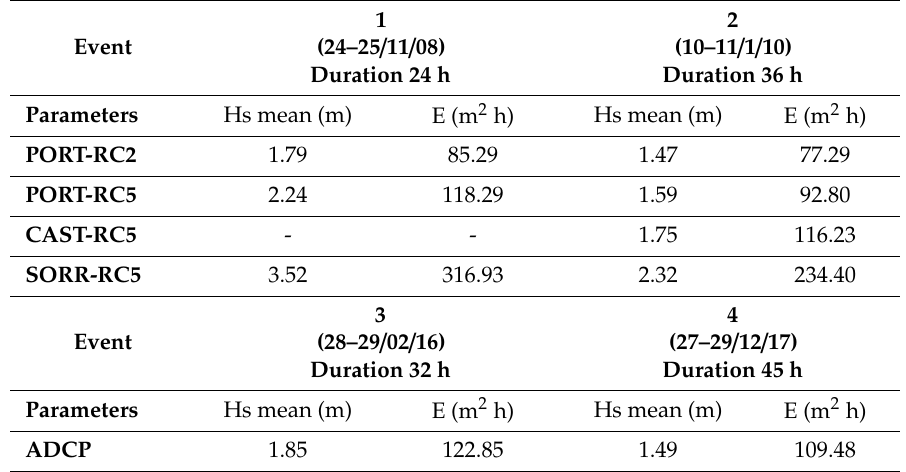
Table 4. Duration (h), Hs mean (m), and energy content E (m 2 h) of extreme events recorded by HF radars and